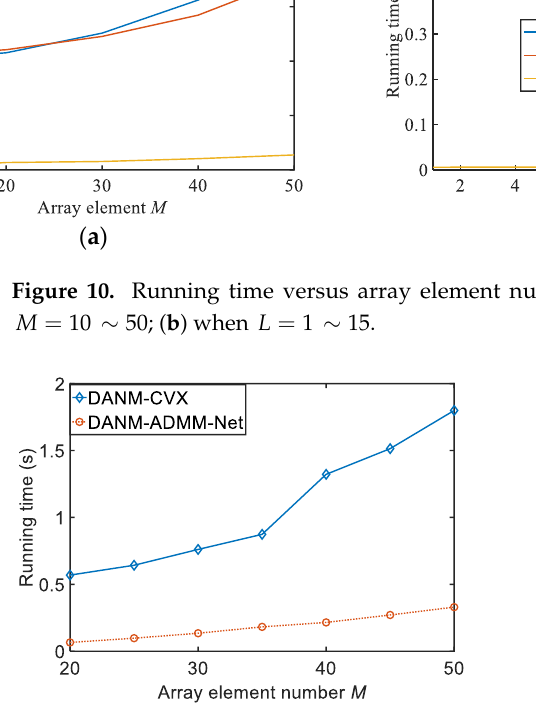
Figure 11. Running time of different methods versus array element number M .